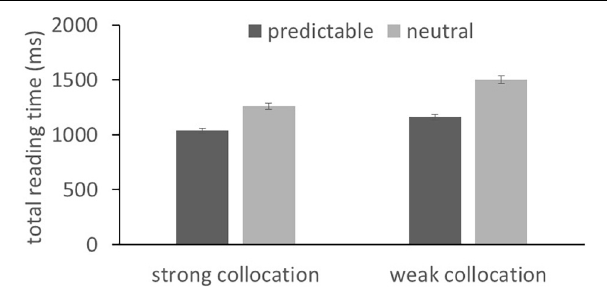
FIGURE 2 | Interactions between collocation strength and contextual predictability in total reading times for the collocation. Error bars correspond to the Standard Error of the